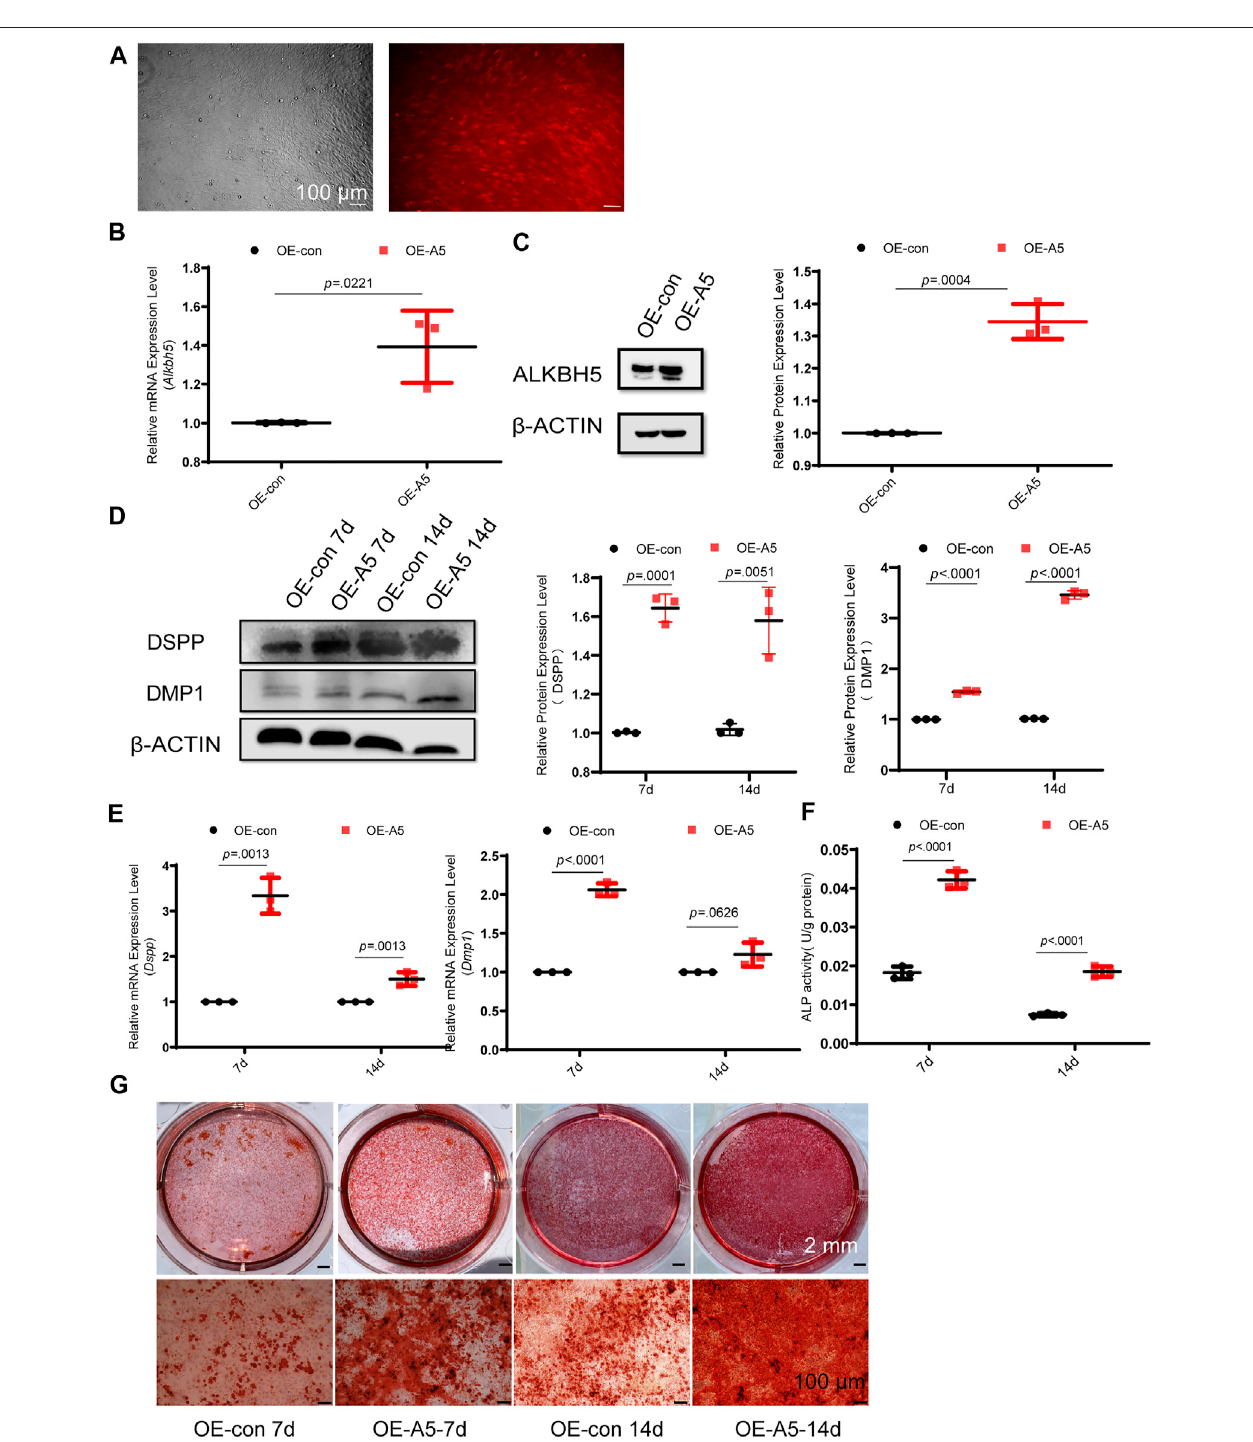
FIGURE 2 | Alkbh5 improved odontoblast differentiation of mDPC6T cells. (A) Transfer ef fi ciency of overexpressed Alkbh5 in mDPC6T cells was detected and observed via red fl uorescent protein labeling under a microscope (see above) after transfection for 72 h. The lower panel shows the immuno fl uorescence images taken simultaneously. Scale bar: 100 μ m (original magni fi cation × 100). (B,C) Alkbh5 expression level was measured via qPCR and western blotting in the Alkbh5 overexpressiongroupandnegativecontrolgroup. (D) TheproteinlevelsofDSPPandDMP1inthe Alkbh5 overexpressiongroupandcontrolgroupweremeasured via western blotting after 7 and 14 days ofodontoblast induction. (E) The mRNA expression levels of Dspp and Dmp1 weremeasured via qRT-PCRafter 7 and 14 days of odontoblast induction. (F) ALP activity wasdetermined. Alkbh5, AlkB homolog H5; Dspp,dentin sialophosphoprotein; Dmp1, dentin matrix acidic phosphoprotein 1; qRT-PCR,quantitativereversetranscription-polymerasechainreaction;ALP,alkalinephosphatase. (G) Mineralizednoduleformationwasanalyzedondays7and14 via AlizarinRedSstaininginthe Alkbh5 overexpressiongroupsandthecontrolgroupundergoingodontoblastinduction.Scalebars:2 mmand100 μ m(highmagni fi cation).